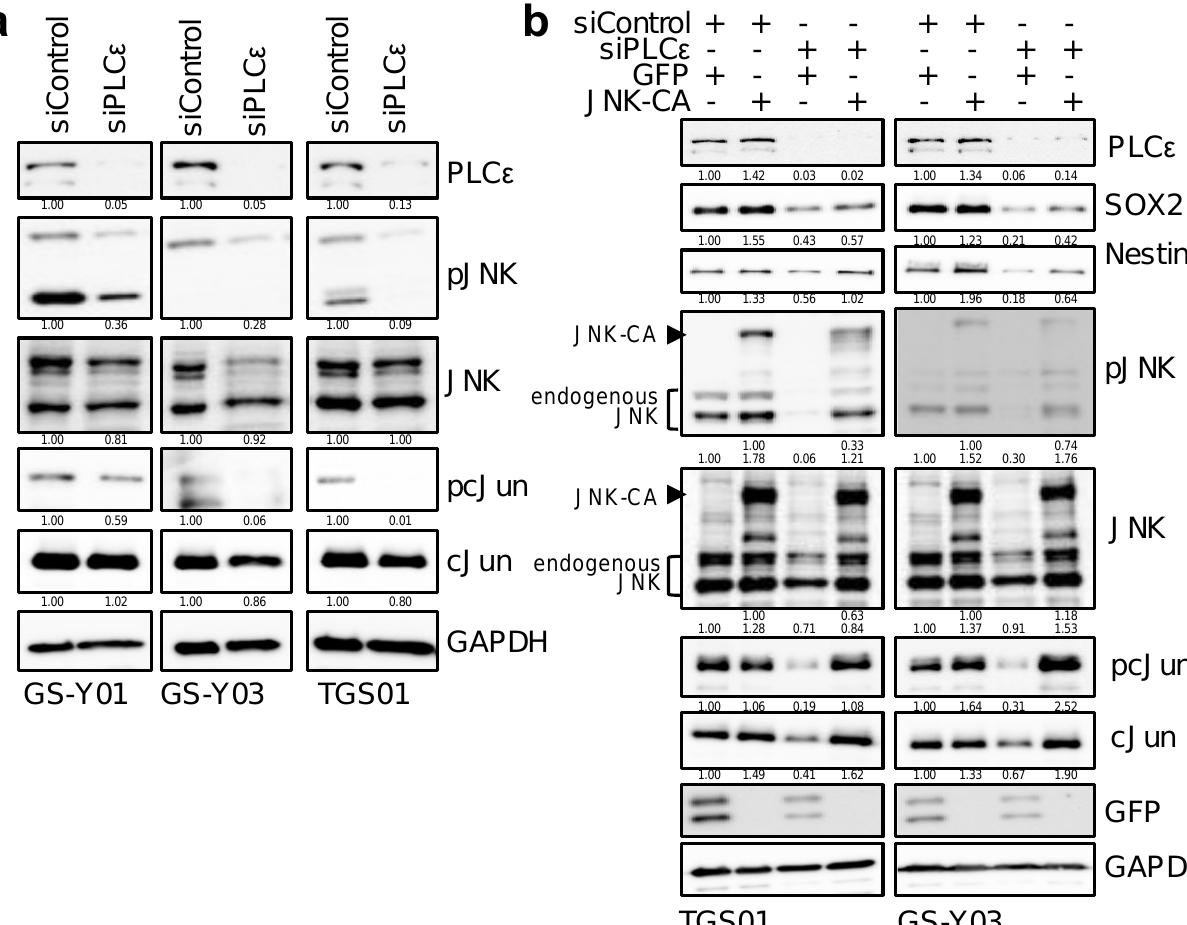
Figure 5. PLC ε silencing suppresses GSC stemness by inhibiting the JNK axis. ( a ) GSCs (GS-Y01, GS-Y03, and TGS01) transiently transfected with siRNA against PLCE1 were subjected to Western blot analyses for the expression of the indicated proteins. ( b ) TGS01 and GS-Y03 cells that were transiently transfected with the activated JNK1 expression plasmid (JNK-CA) or control vector (GFP) for 24 h were transiently transfected with siRNA against PLCE1 or control siRNA for 4 days. The indicated proteins were detected by Western blotting. Similar results were obtained from two independent biological replicates. The numbers below the Western blot images show the relative band intensities after each band was quantified by densitometry and normalized by the GAPDH value.